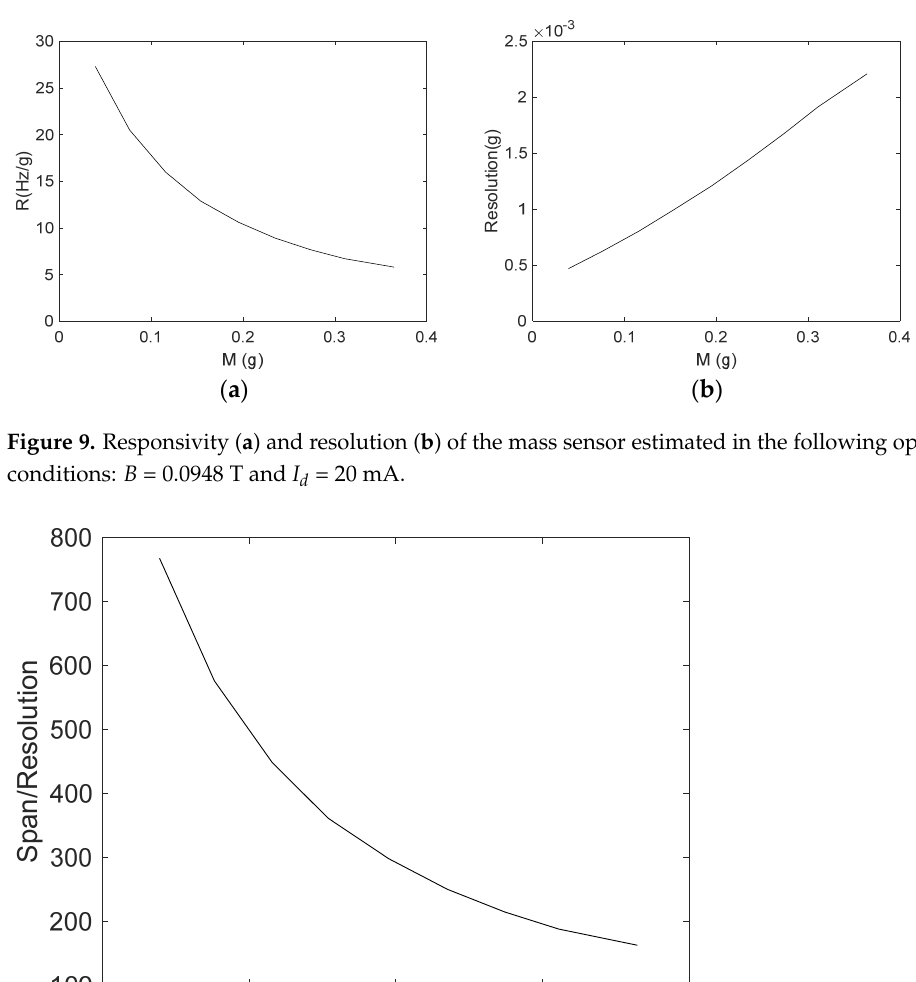
Figure 8. ( a ) Sensor response in the case of the following operating conditions: B = 0.0948 T and I d = 20 mA. Model (10) has been used to fit experimental data. ( b ) Calibration Diagrams for the same operating conditions, obtained by inverting model (10). A coverage factor of 2 has been used for the uncertainty bandwidth.